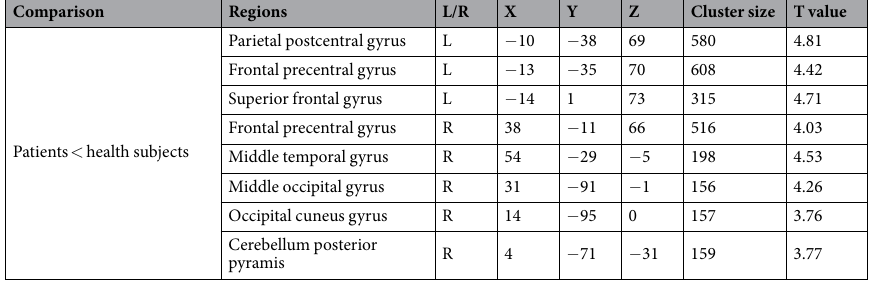
Table 2. Gray matter volume comparison between drug-naïve, first-episode schizophrenia patients and healthy controls.